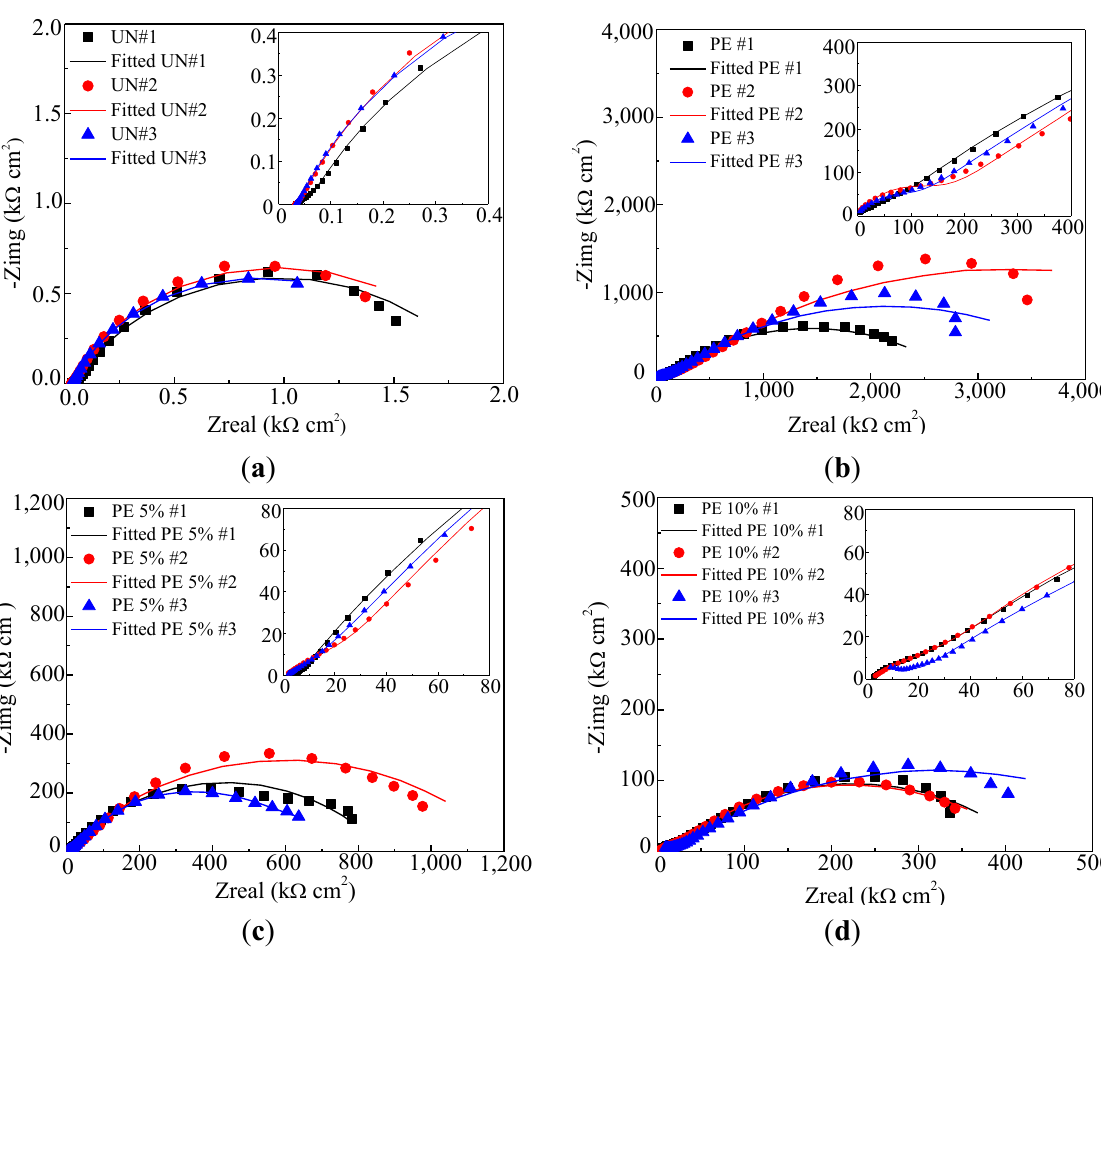
Figure 3. Typical EIS diagrams of smooth steel bars: ( a ) uncoated (UN); and ( b – h ) coated with pure enamel (PE) modified with 0%, 5%, 10%, 20%, 30%, 50% and 70% sand particles by